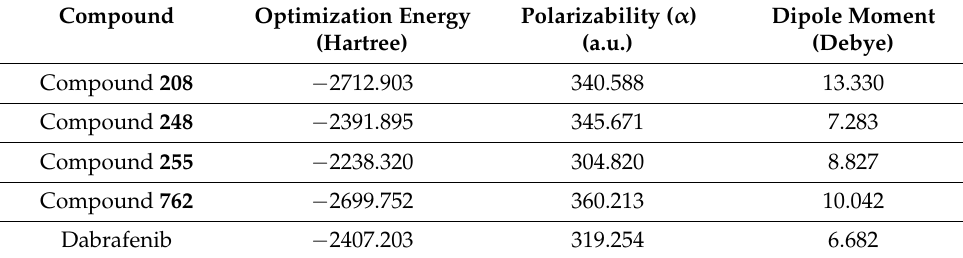
Table 1. Energetic parameters of top hits and standard